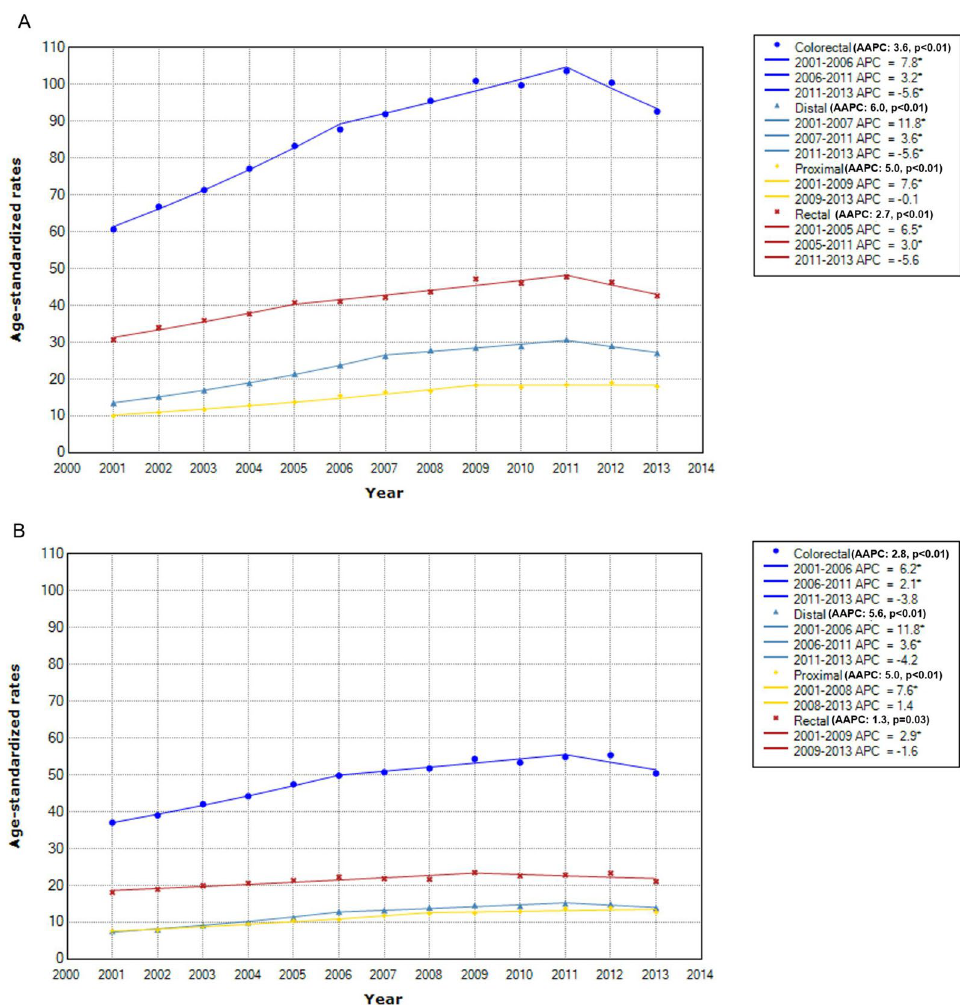
Figure 1. Time trend of colorectal cancer incidence rates by sex and anatomical subsite. *Indicates that APC is significantly different from zero at the alpha = 0.05 level. ( A ) In men. ( B ) In